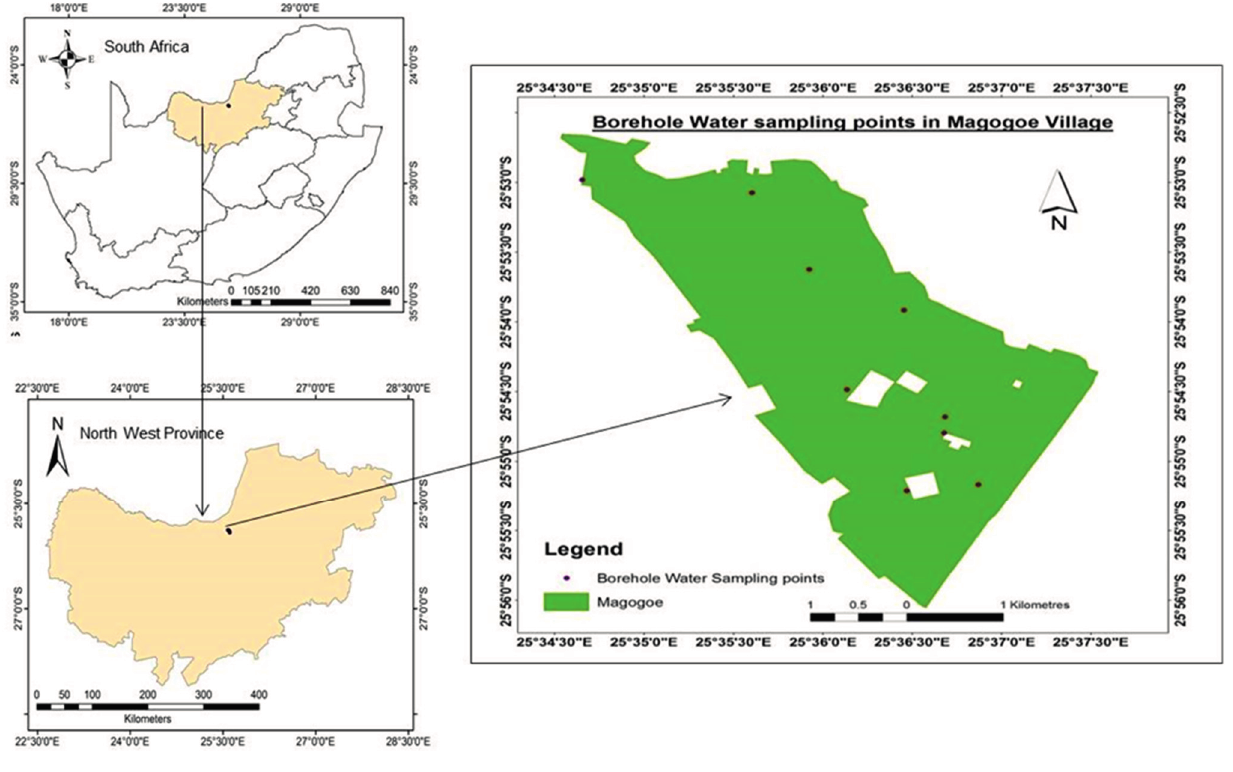
Figure 1. Map of the study area within South Africa and sampling